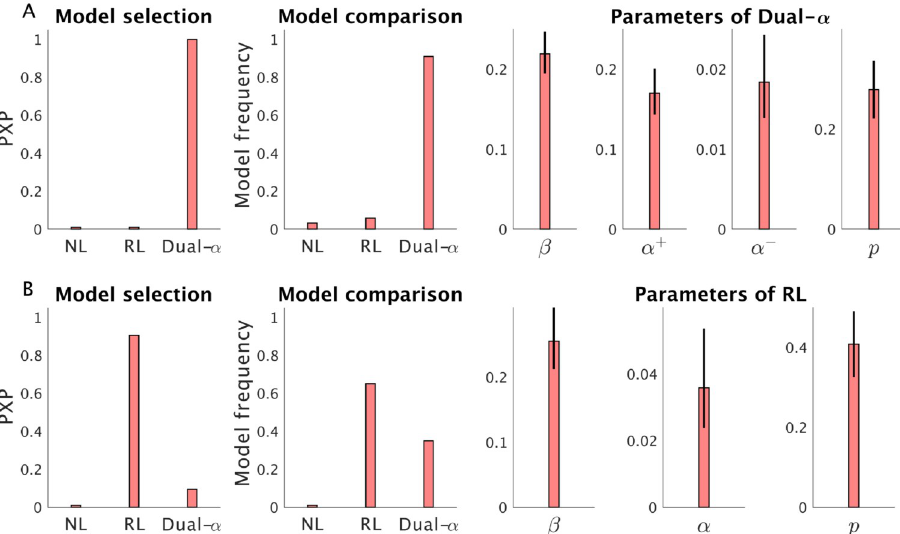
Fig 14. Using HBI for making inference on Parkinson’s patients data. A) HBI has been applied to a dataset of 31 PD patients performing a probabilistic reward and punishment learning task. The model space consisted of a null non- learning (NL) model, RL, and the dual- α RL. Protected exceedance probabilities (PXP), model frequencies and estimated parameters of the winning model (the dual- α RL) are plotted. The HBI revealed that the dual- α RL is more likely across PD patients. B) The same model space was fitted to a dataset of 20 healthy control subjects performing the same task. In contrast to PD patients, the RL model is more likely across the control group. In addition to the decision noise, β , and learning rate parameters, both RL models also modeled tendency to repeat or avoid the previous choice regardless of outcomes using a perseveration parameter, p . A permutation test revealed that the dual- α model is more likely than the RL model in PD compared with the controls. The error-bars are obtained by applying the corresponding transformation function on the hierarchical errors and, therefore, are not necessarily